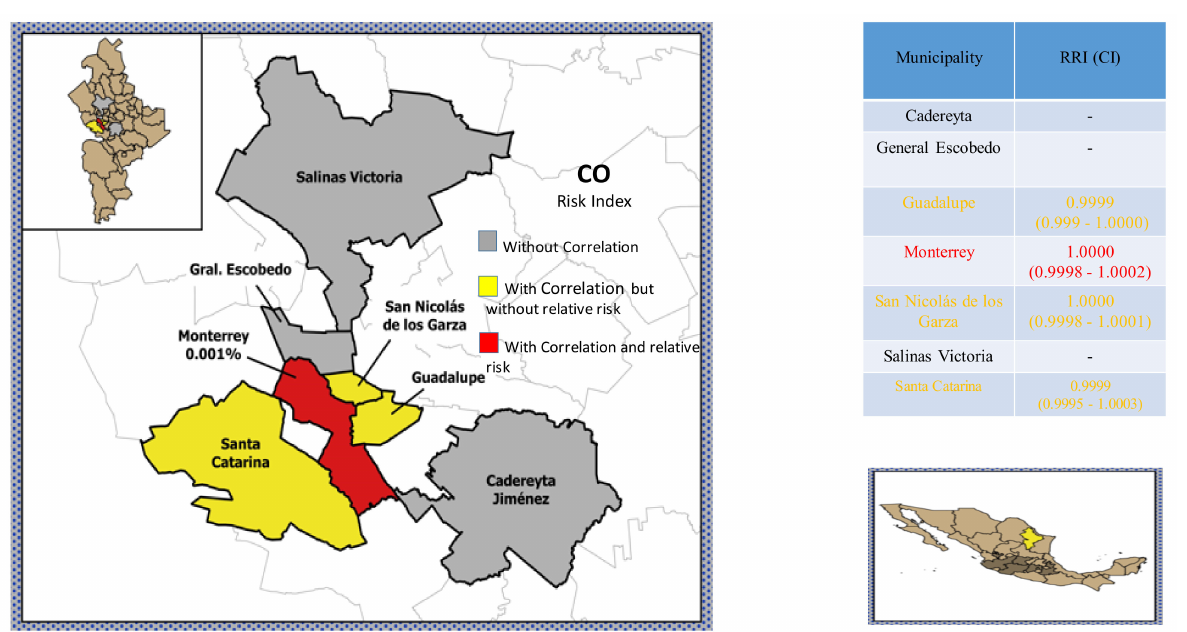
Figure 11. Relative risk indexes in MAM for the hypothetical scenario in which daily mean concentrations for CO increased by 10%, considering all